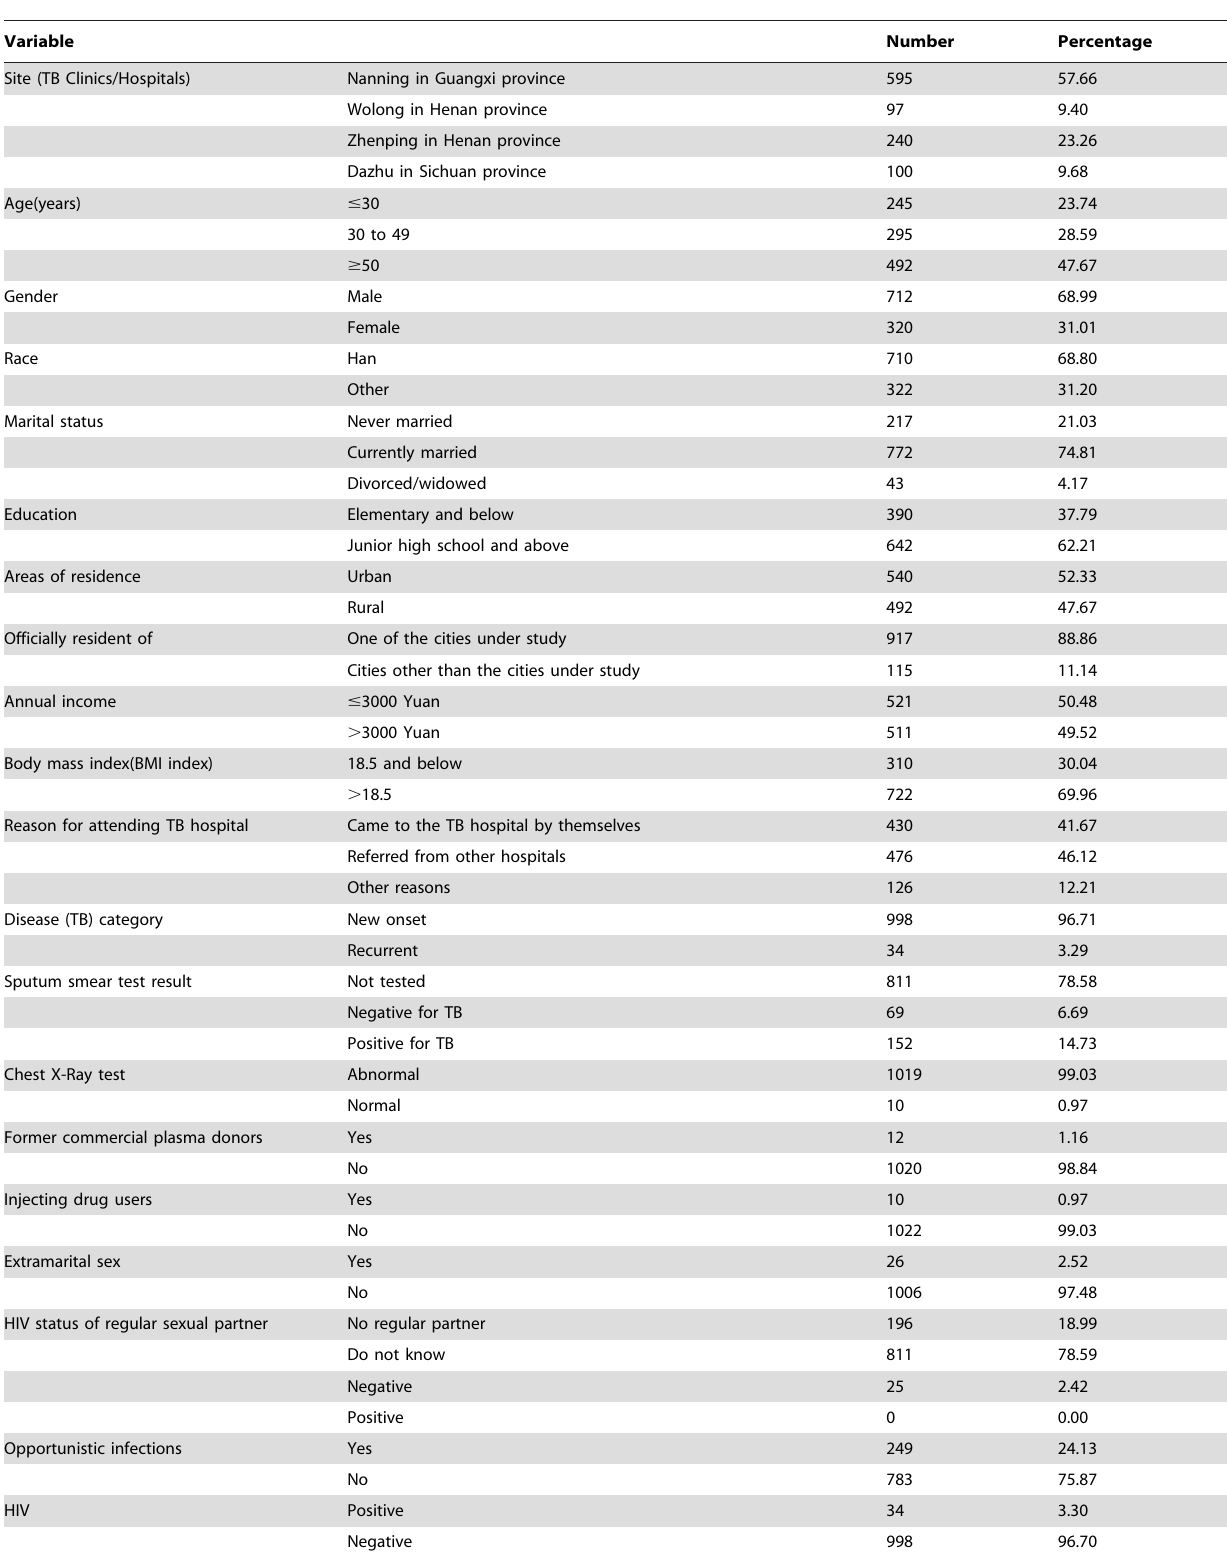
Table 1. Socio-behavioral and clinical characteristics along with HIV sero-positivity among participating tuberculosis (TB) patients in three provinces of China, 2010